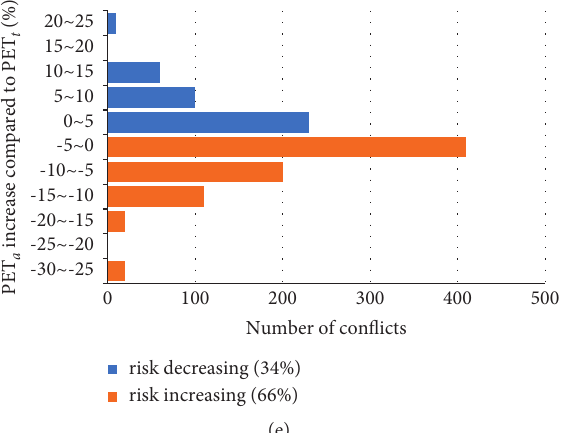
Figure 8: Conflict risk changes due to left-turn path divergence. (a) 500veh/h/lane. (b) 600veh/h/lane. (c) 700veh/h/lane. (d) 800veh/h/ lane. (e) 900veh/h/lane.